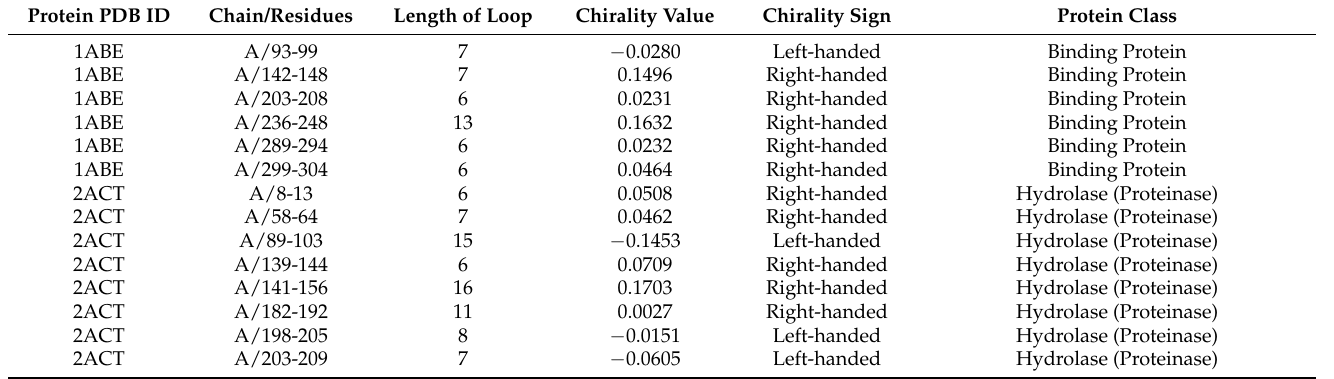
Table A3. The calculated parameters of Ω